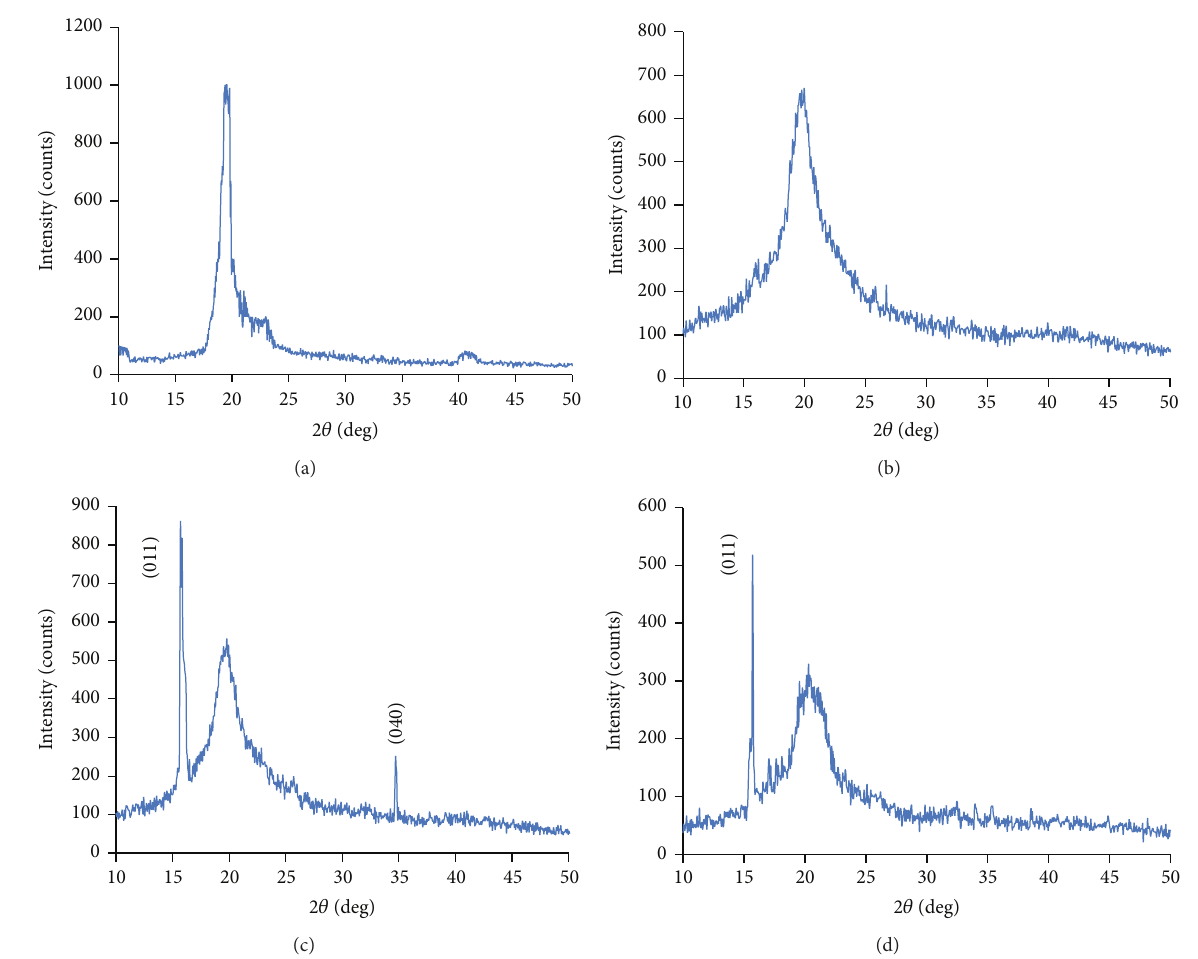
Figure 2: XRD pattern for PVAc/[Co(NH 3 ) 5 Cl]Cl 2 composites film with different concentrations: (a) pure PVAc, (b) 3wt.% (c) 6wt.%, and (d) 9wt.%.